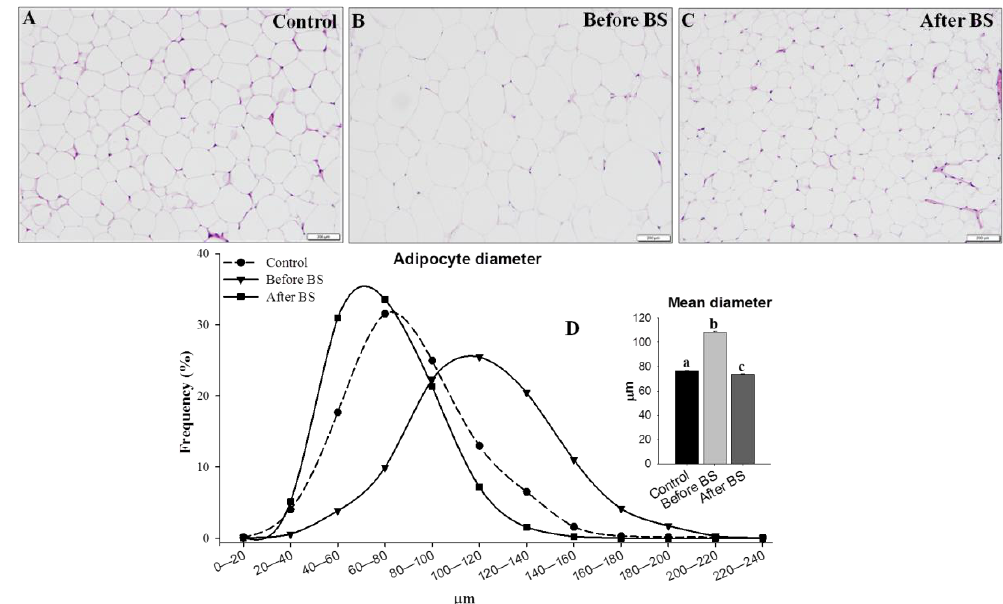
Figure 7. Adipocyte size distribution. The difference in adipocyte size is evident in representative H&E stained samples of aSAT from lean control patients ( A , n = 14), obese patients before bariatric surgery ( B , n = 14) and the same patients after bariatric surgery and normalization of body weight ( C , n = 6). ( D ) The mean frequency of adipocyte diameter, indicating that obese patients before BS have greater numbers of adipocytes with diameters > 80 μm and fewer adipocytes with diameters < 80 μm when compared to control or obese patients after BS. Bars = 200 μm. Values are means ± SEM (histogram). Different letters above the bars indicate statistically significant differences, p < 0.05. BS = bariatric surgery.